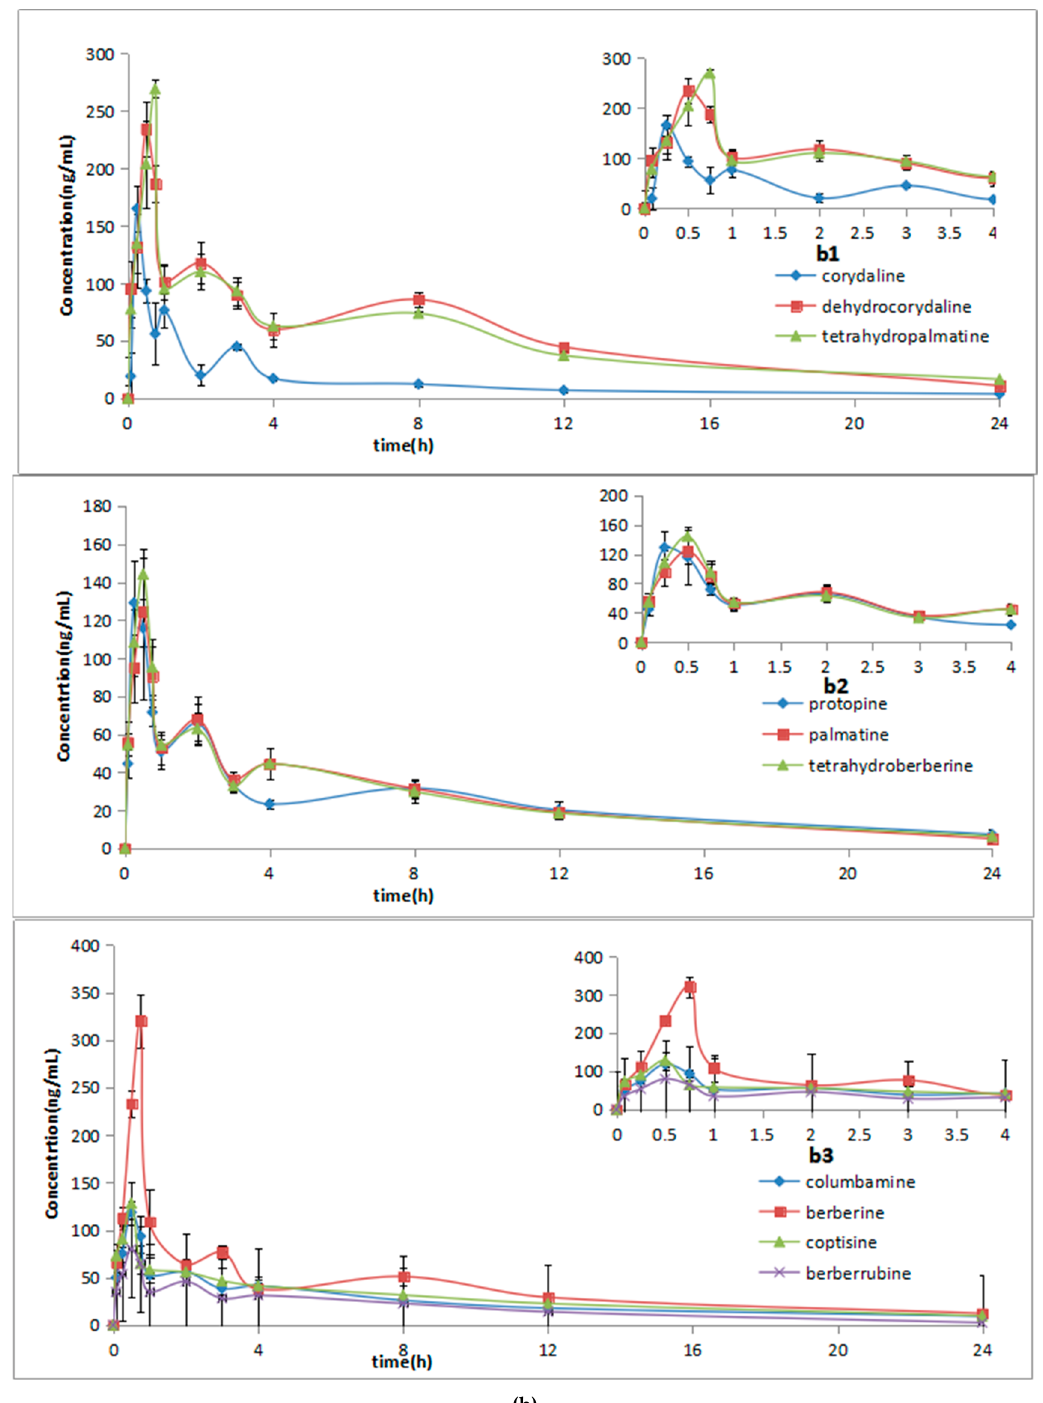
Figure 3. The mean ± SD plasma concentration-time profiles of the 10 alkaloids in the beagle dog plasma after oral administration of C. yanhusuo extract ( a ) and Yuanhuzhitong Tablets ( b ), respectively. The mean ± SD plasma concentration-time profiles of the 10 alkaloids in the beagle dog plasma after oral administration of C. yanhusuo extract ( a1 , a2 , a3 ) and Yuanhuzhitong Tablets ( b1 , b2 , b3 ) from 0 to 4 h, respectively ( n = 6).